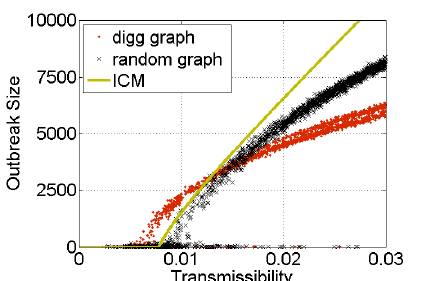
Figure 1. Size of simulated outbreaks on a real-world and random graphs as a function of transmissibility. Contagions are simulated using the independent cascade model (ICM) on the follower graph of the Digg social news platform ( red dots ) and a random graph with the same degree distribution ( black crosses ). The golden line gives theoretically predicted outbreak sizes.